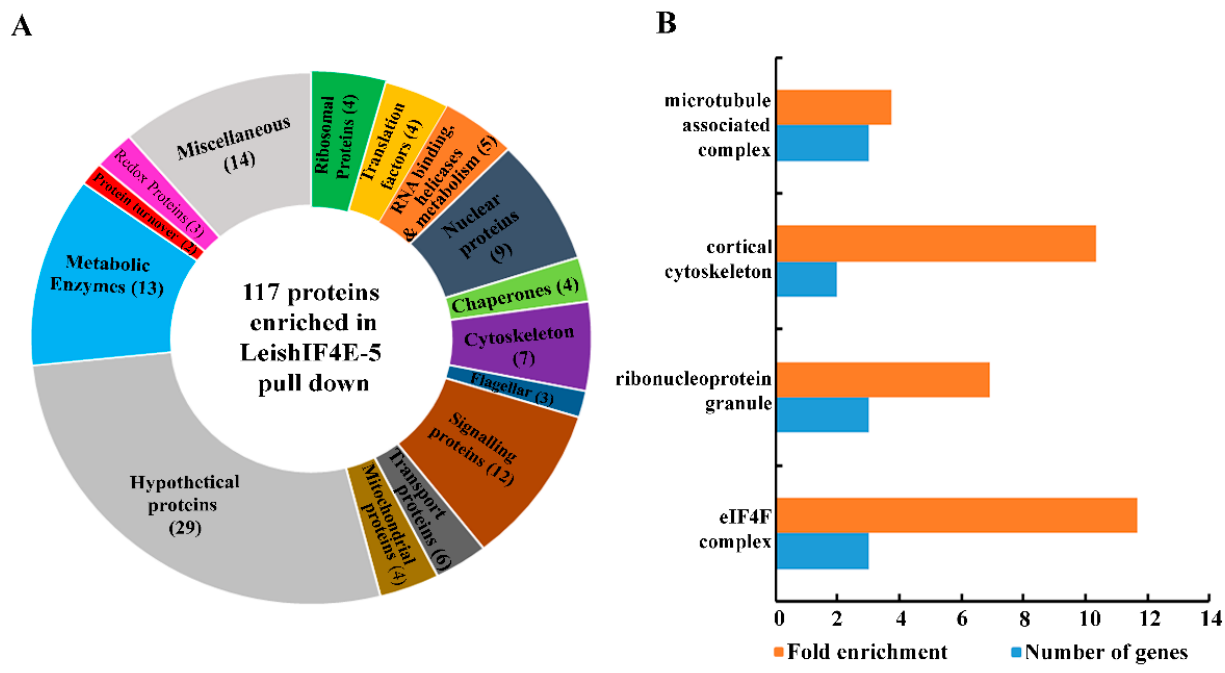
Figure 5. Categorized proteins found enriched with LeishIF4E-5. SBP-LeishIF4E-5 and its associated proteins were pulled- down over streptavidin-Sepharose beads. Control pull downs were performed with cells expressing SBP-luciferase. The proteomic content of the pulled-down extracts was assessed by LC-MS/MS. Proteins were identified using the MaxQuant software and their enrichment as compared to the luciferase control was determined using the Perseus statistical tool, highlighting a log 2 fold change of ≥ 1.6, with an adjusted p value (Padj) < 0.05. A total of 117 proteins were found to be significantly enriched in the interactome of SBP-LeishIF4E-5 that served as the bait protein. The proteins were categorized into groups according to their annotated functions. ( A ) The pie chart shows the relative distribution of proteins that were manually categorized into functional groups. The pie chart shows the relative abundance of each category, based on the summed intensities of the peptides that were used to identify the individual proteins. The numbers in brackets in the pie chart represent the number of proteins in each category. ( B ) Gene Ontology (GO) term enrichment by cellular components. The resulting GO terms were enriched by at least three-fold as compared to the gene sets encoded in the genome, with a p value ≤ 0.05.